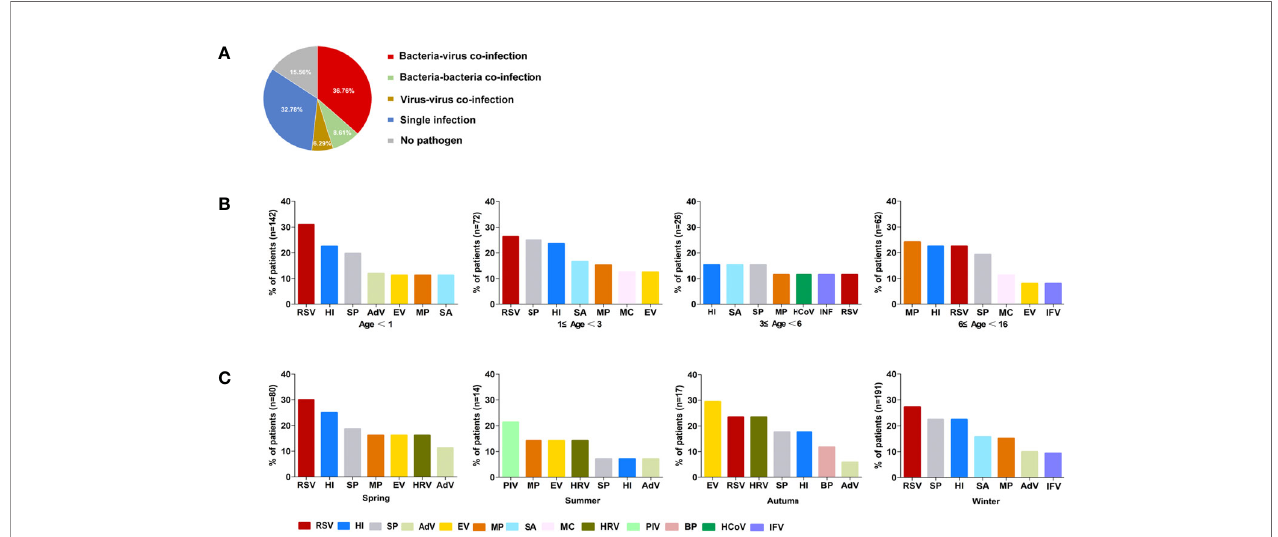
FIGURE 2 | The etiology of 302 included children de fi ned by combined-MS methods. (A) The proportions of different patterns of infection. (B) Distribution of main pathogens in patients with different age groups. (C) Seasonal prevalence of main pathogens. RSV, respiratory syncytial virus; HI, Haemophilus in fl uenzae ; SP, Streptococcus pneumoniae ; MP, Mycoplasma pneumoniae ; SA, Staphylococcus aureus ; EV, Enterovirus; AdV, Adenovirus; IFV, In fl uenza virus; HRV, Human rhinovirus; MC, Moraxella catarrhalis ; PIV, Parain fl uenza virus; BP, Bordetella pertussis ; HCoV, Human coronavirus.